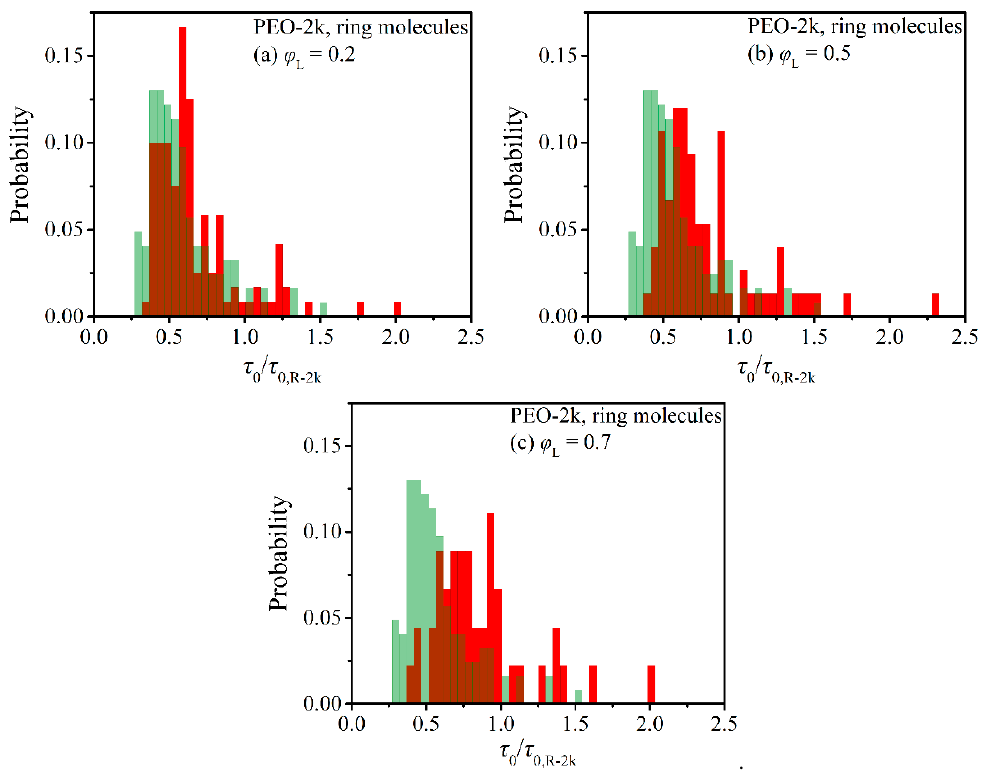
Figure 5. Histograms (red bars) of the characteristic ring orientational relaxation times in the simulated PEO-2k blends as a function of the fraction of linear chains: ( a ) ϕ L = 0.2, ( b ) ϕ L = 0.5, ( c ) ϕ L = 0.7. Green bars represent the corresponding histograms in the pure ring melts from Ref. [25].